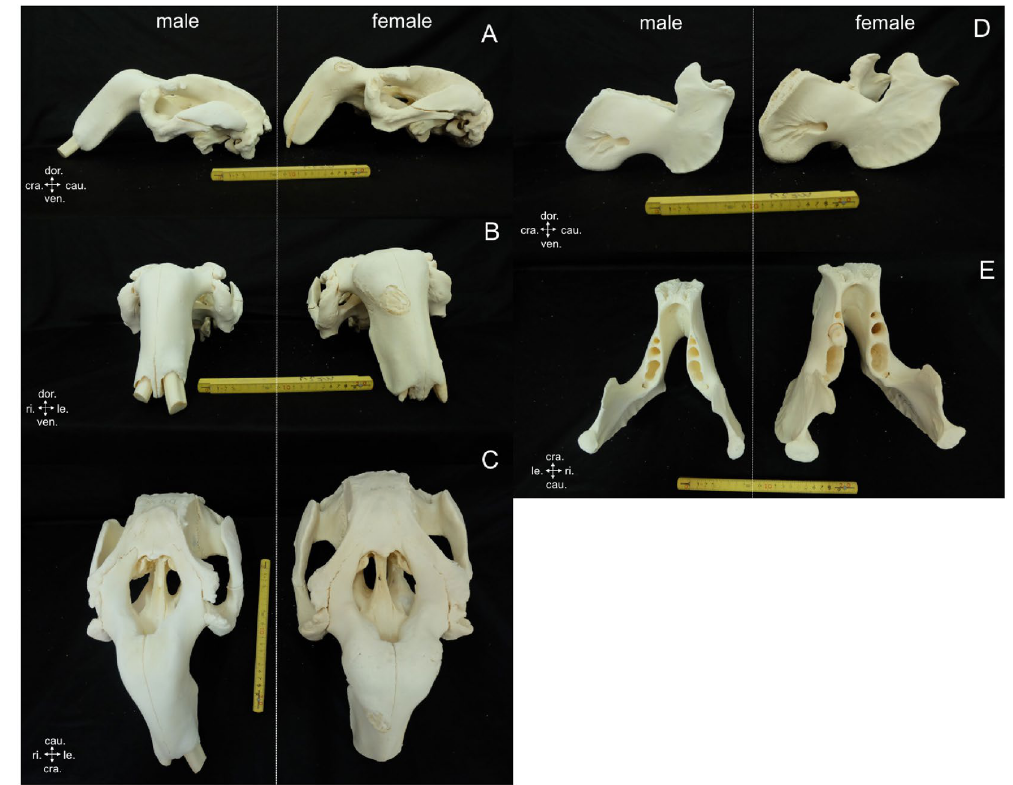
Figure 4. Comparative morphology of the cranium ( A–C ) in male (DU364) and female (DU335) dugongs revealed no significant hallmarks to distinguish males and females: left lateral view ( A ), cranial view ( B ) and dorsal view ( C ). However, the female cranium appears larger than that of the male. Comparative morphology of the male and female mandible, left lateral view ( D ) and dorsal view ( E ), also did not find markers for sex indentification. The female mandible was also larger than the male mandible. (cra. = cranial, cau. = caudal, dor. = dorsal, le. = left, ri. = right, ven. = ventral).